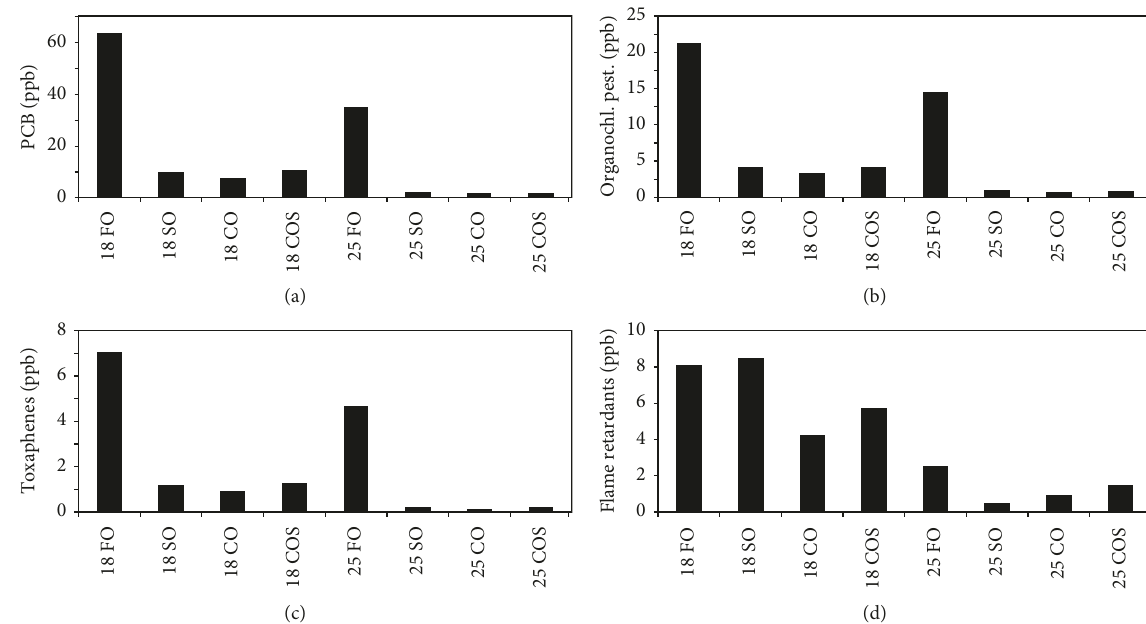
Figure 1: Concentrations of (a) PCBs (ppb), (b) organochlorine pesticides (ppb), (c) toxaphenes (ppb), and (d) flame retardants (ppb) in experimental diets. 18 FO, 18 DP/DE diet with 100% fish oil; 18 SO, 18 DP/DE diet with 75% soybean oil; 18 CO, 18 DP/DE diet with 75% canola oil; 18 COS, 18 DP/DE diet with 75% blend of canola oil and Schizochytrium sp.; 25 FO, 25 DP/DE diet with 100% fish oil; 25 SO, 25 DP/DE diet with 75% soybean oil; 25 CO, 25 DP/DE diet with 75% canola oil; 25 COS, 25 DP/DE diet with 75% blend of canola oil and Schizochytrium sp.; DM, dry matter; DP/DE, digestible protein/digestible energy (lipids).